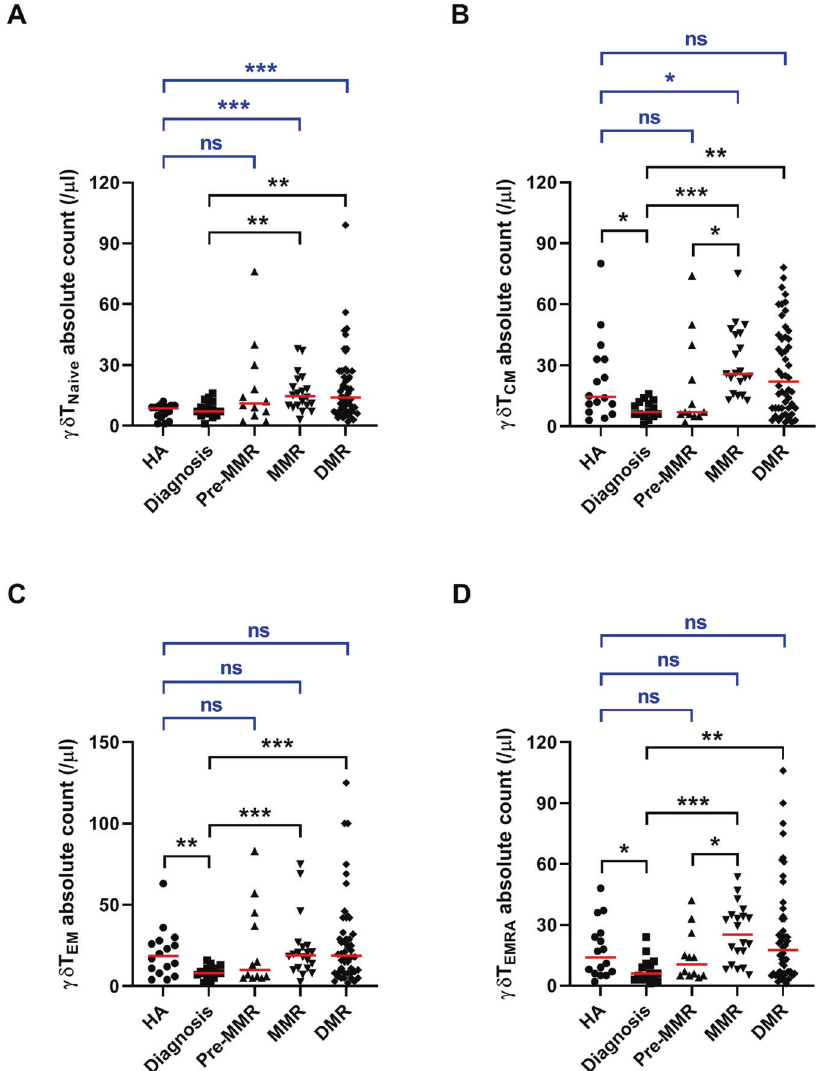
Fig. 2 Phenotypic characterization of γδ T-cell subsets. PBMCs were stained with antibodies reacting to CD3, TCR γδ T, CD45RA, and CD27. Upon the analysis on gated CD3 + TCR γδ T + cells, the four γδ T subsets were identi fi ed as ( A ) naïve, B T CM , C T EM , and D T EMRA . The cell number of each γδ T subset in PB were calculated based on the total lymphocyte count. Signi fi cant differences were found among γδ T subsets isolated from healthy controls and from CML patients at different disease states. Data comparison was performed by the Student ’ s t test; if